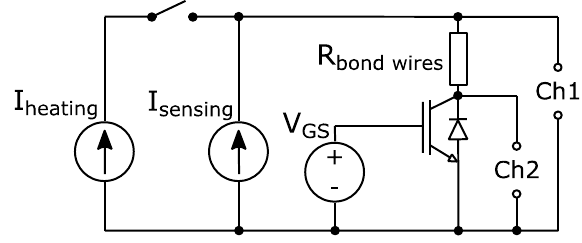
Figure 14. Schematic of the measurement setup used for the “bond wire cut test”.